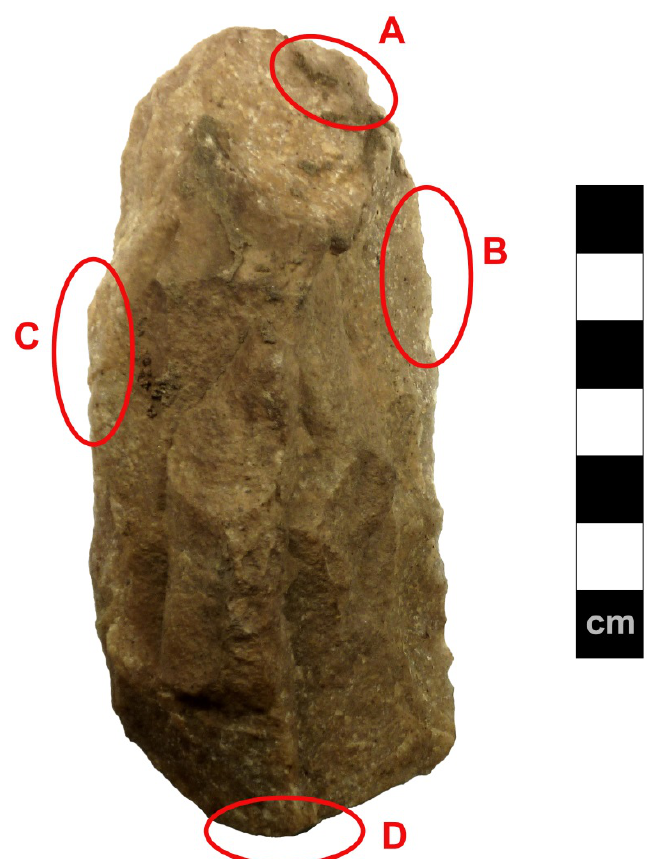
Figure 6 Unifacially reduced artifact found at Lapa de Taquaraçu archaeological site, with the signalized areas where sediment was recovered for starch. A: distal area; B: right area; C: left area; D: proximal area. Photo by João Carlos Moreno da